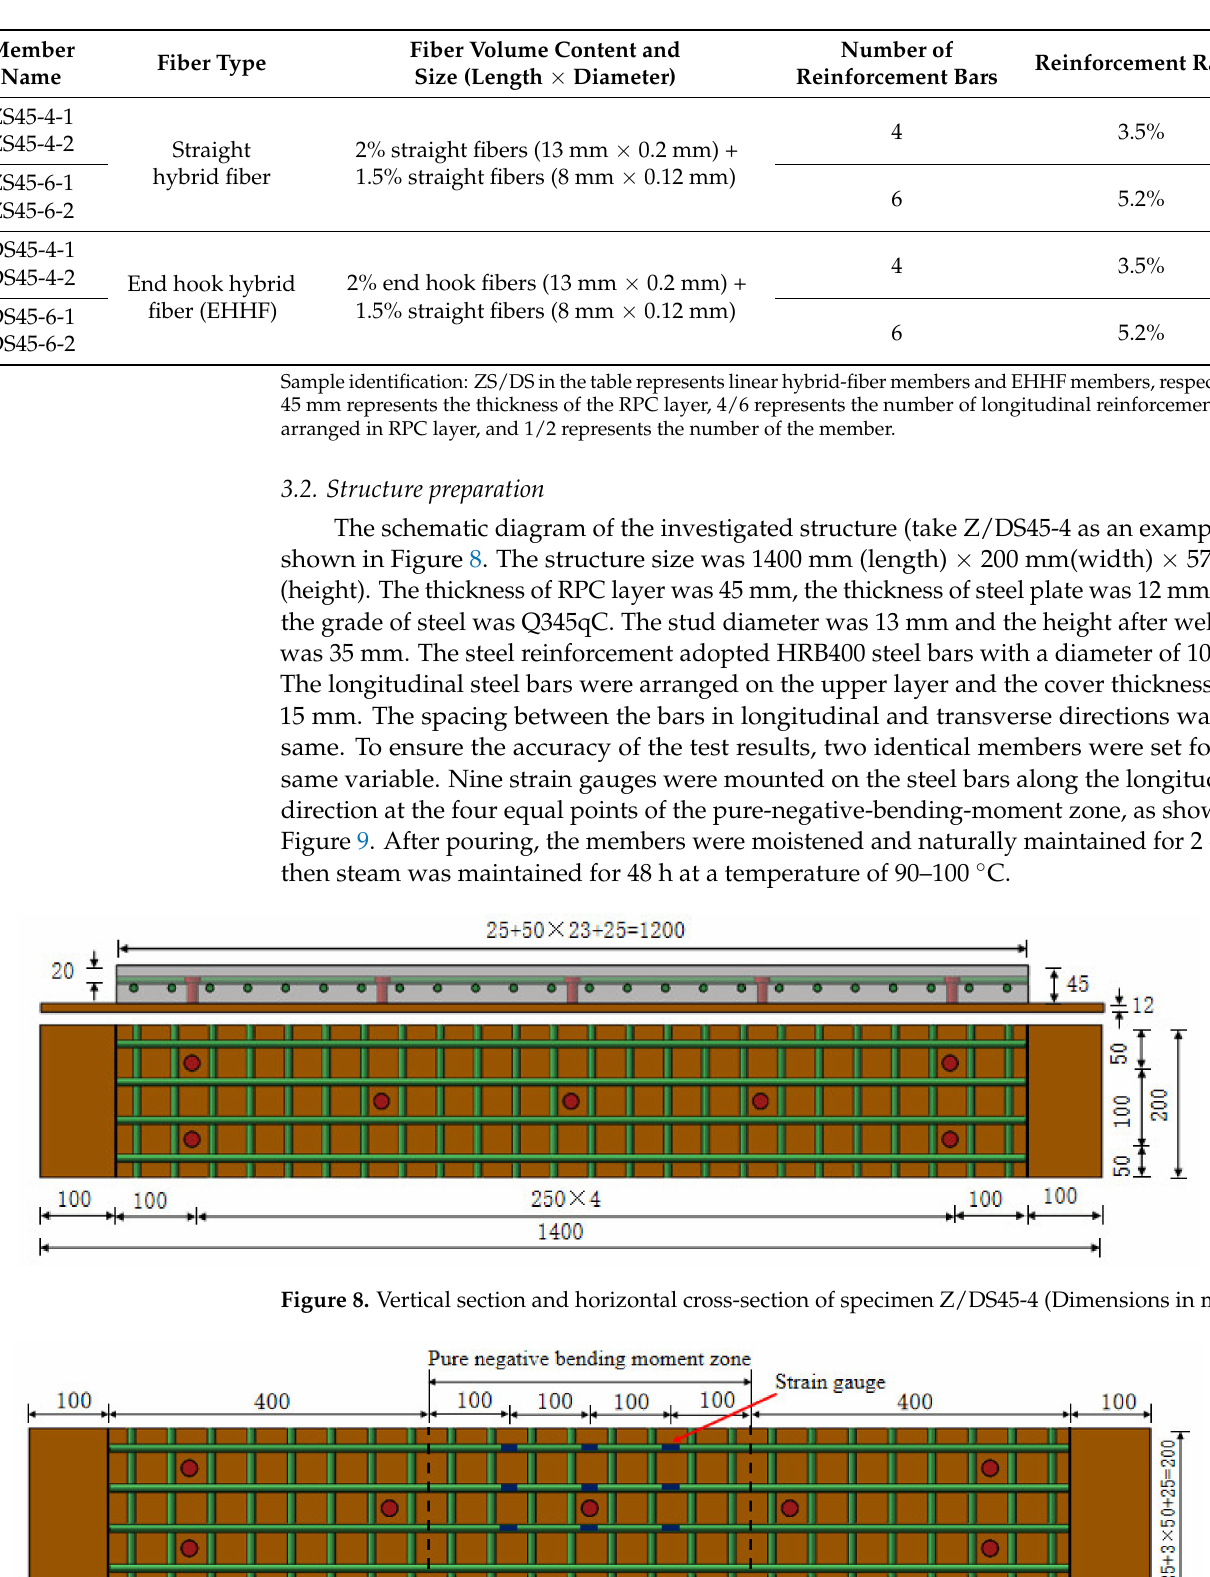
Table 4. Parameter of members.